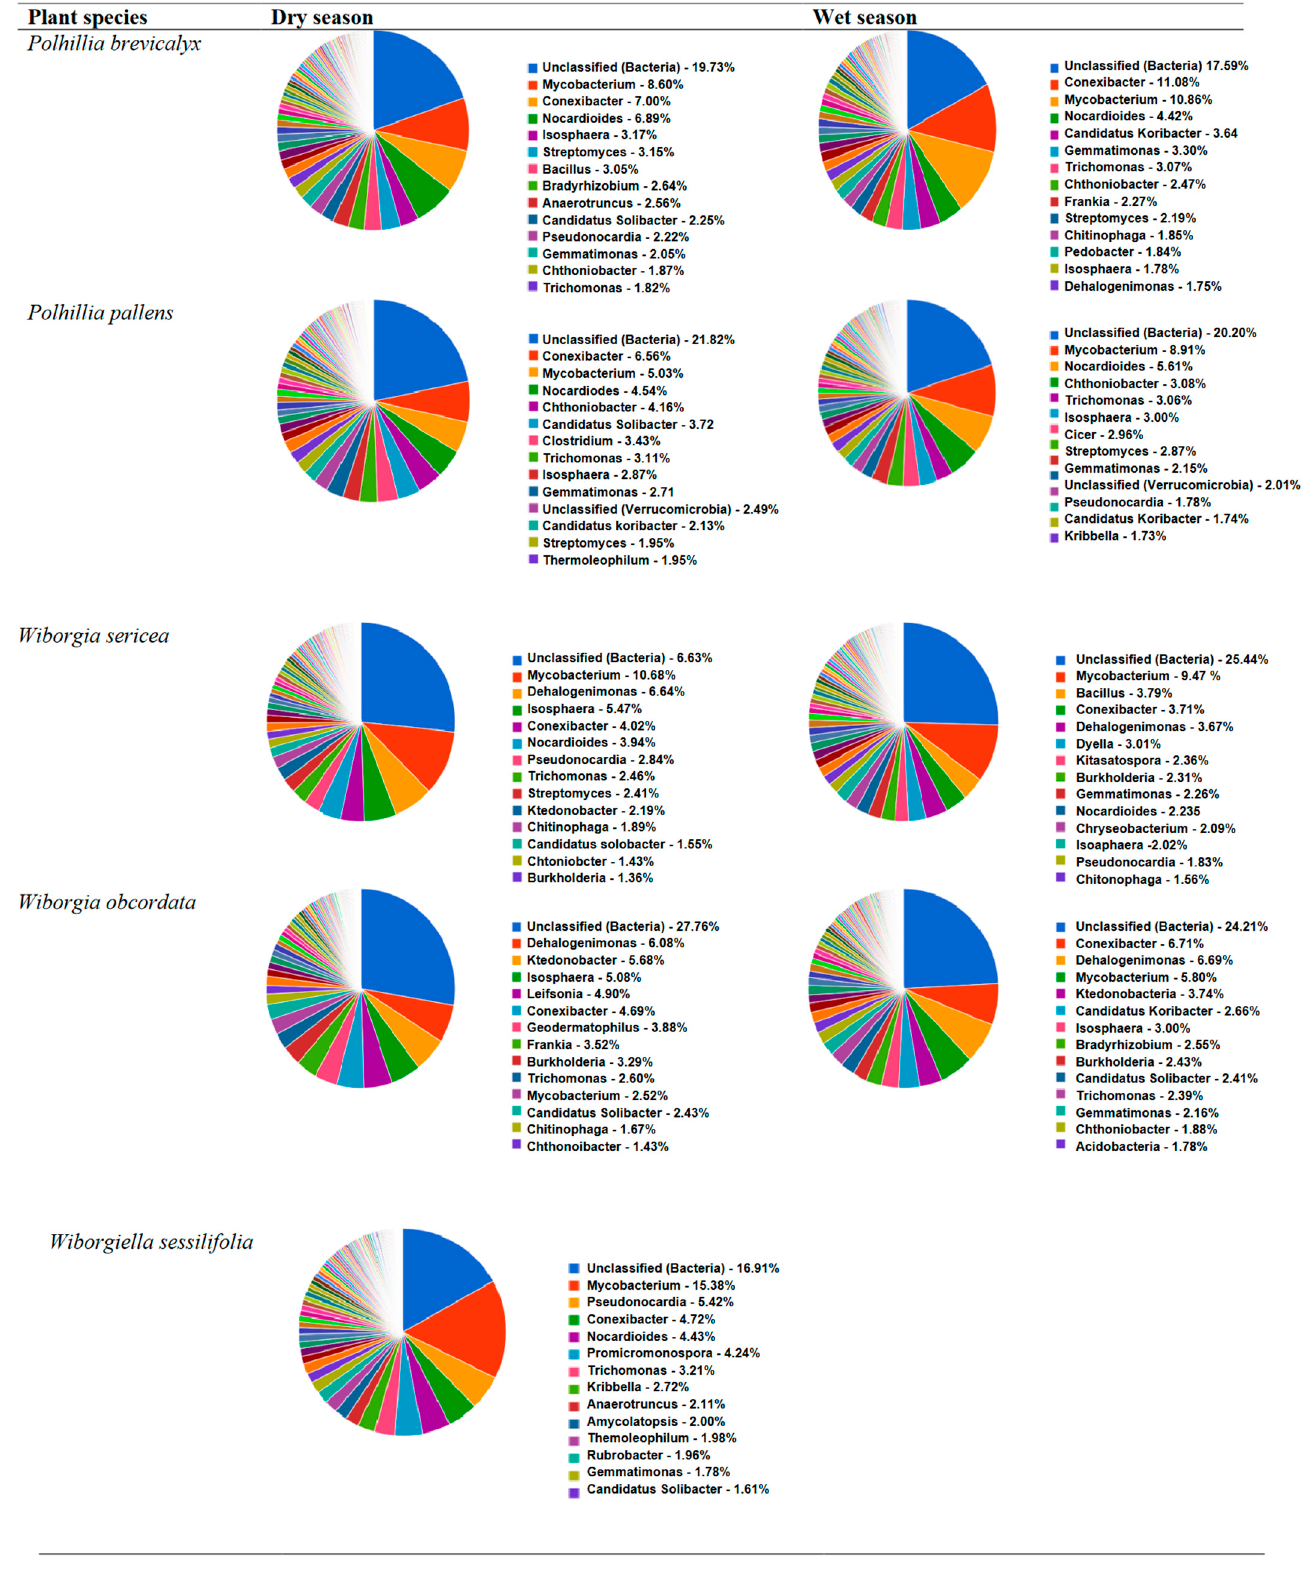
Figure 3. Taxonomic distribution based on 16S rRNA sequences described up to genus level in rhizosphere soils of Polhillia brevicalyx and Polhillia pallens sampled during the wet and dry seasons at the Cape fynbos biome, South Africa.